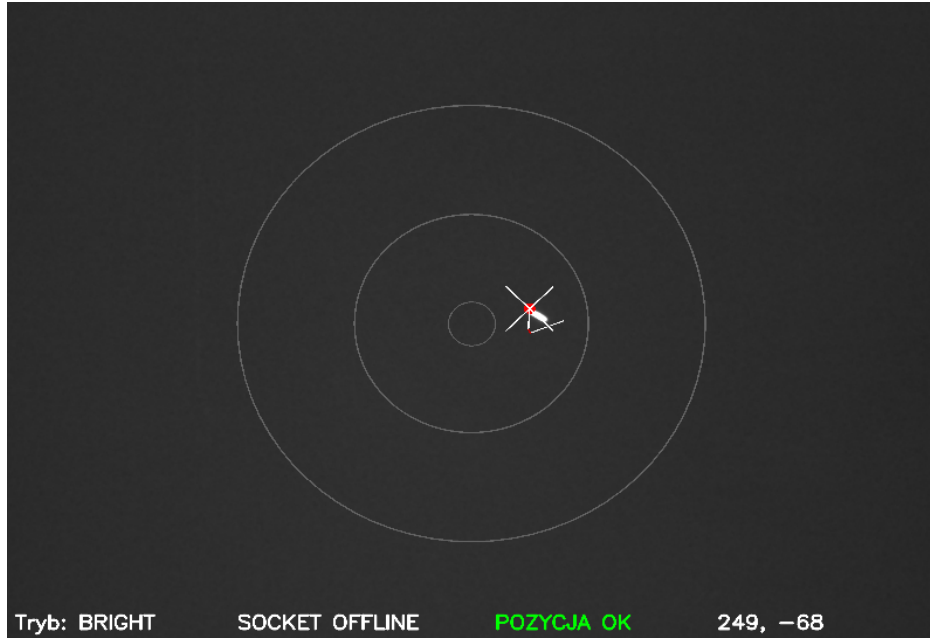
Figure 9. Object extraction and position determination